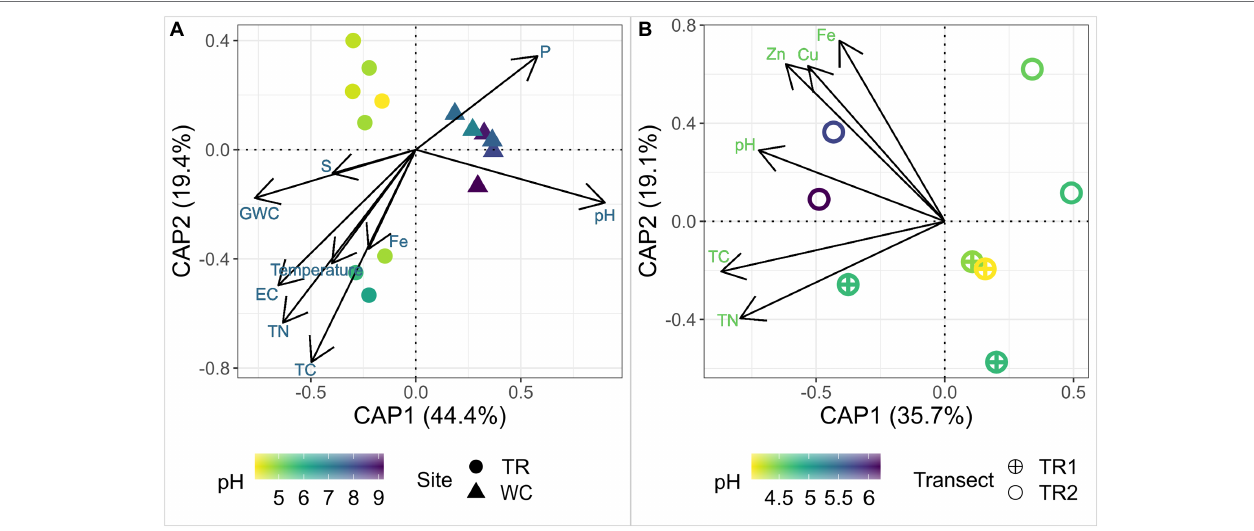
FIGURE 3 | A distance-based Redundancy Analysis (dbRDA) of 16S rRNA gene ASV profiles, which were center log-ratio transformed and constrained by the physicochemical parameters identified as significantly (Mantel test, p < 0.05) affecting the microbial community composition either (A) between Western Crater and Tramway Ridge, or (B) within Tramway Ridge. Ordination was constructed using Unifrac distances among samples. The shape represents the site/transect of origin for the sample, color represents the pH of the sample as pH was identified as being most important for distinguishing samples between sites. The percentages on the axes correspond to the variance in biological samples explained by the combination of the selected environmental parameters. The arrow direction for each environmental factor represents the variance direction for that parameter. TR: Tramway Ridge site; WC: Western Crater site; TR1: Tramway Ridge transect 1; TR2: Tramway Ridge transect 2; GWC: gravitational water content; EC: electroconductivity; TC: total carbon; TN: total